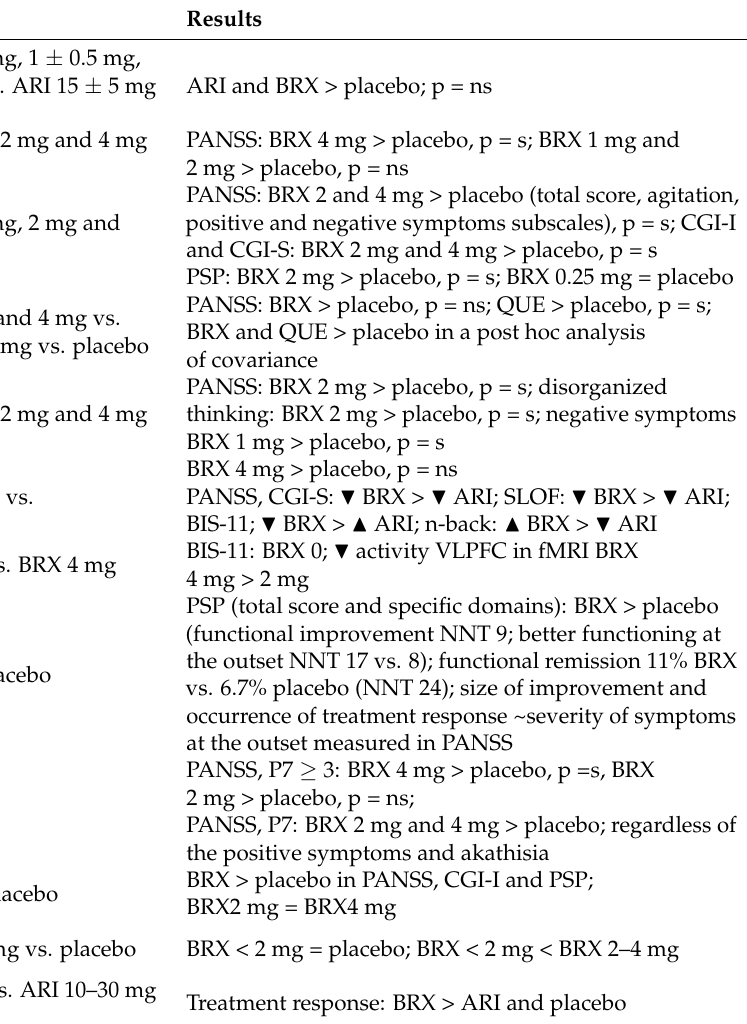
Table 2. The studies on acute schizophrenia episode treatment with the use of